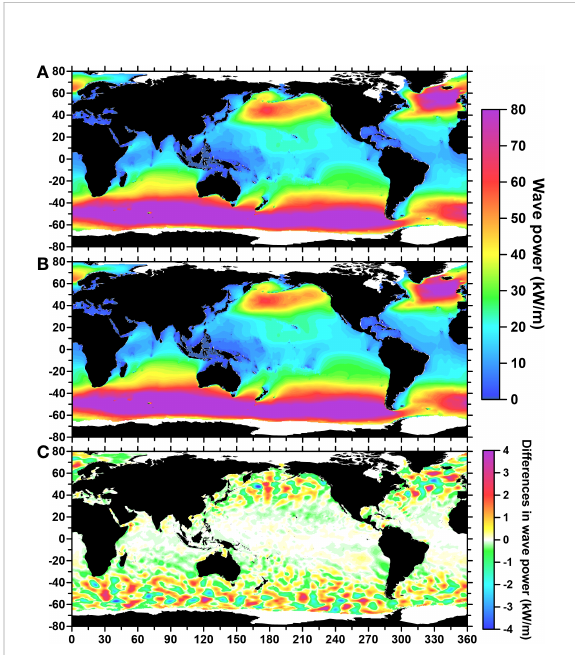
FIGURE 7 Wave power distribution in the day and night. (A) Day, (B) night, and (C) the differences in wave power between the two.